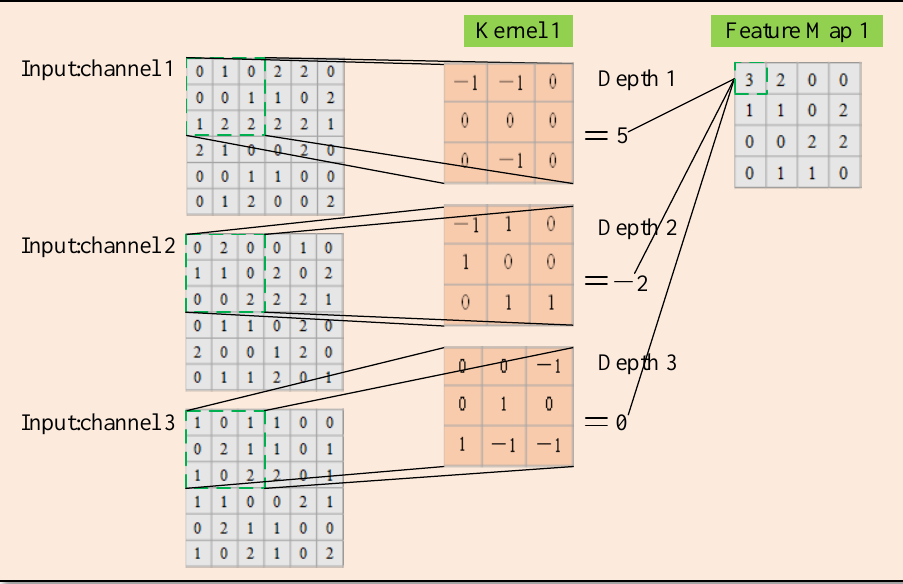
Figure 2. The process of convolution calculation.